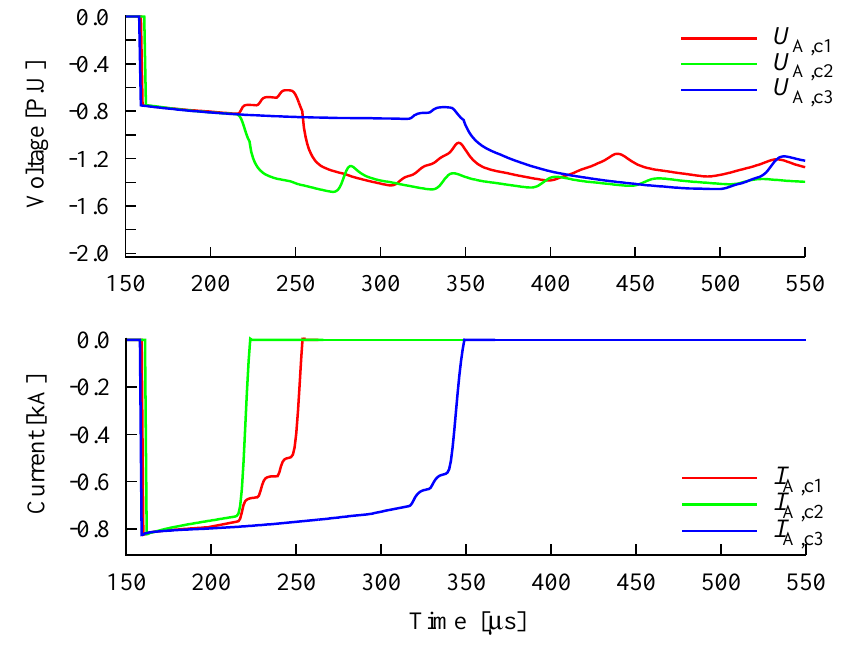
Figure 14. Simulated sending end voltages and currents for the three study cases for phase